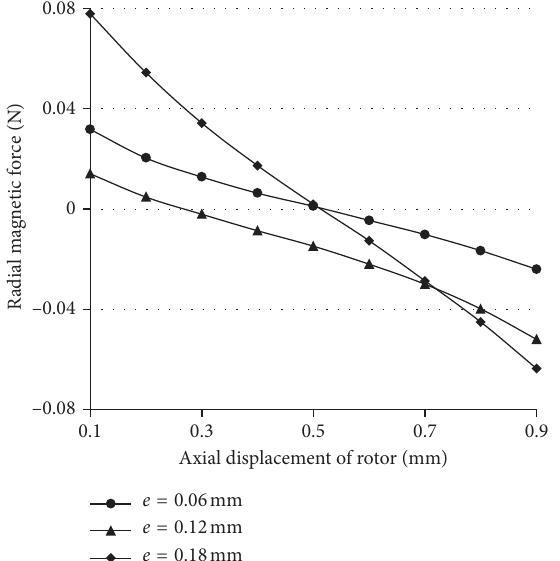
Figure 8: Yaw torques of magnetic bearings acting on the rotor in different axial positions and deflections around z